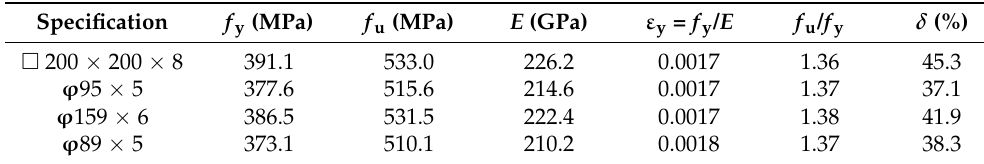
Table 2. Test result of steel tubular material properties.